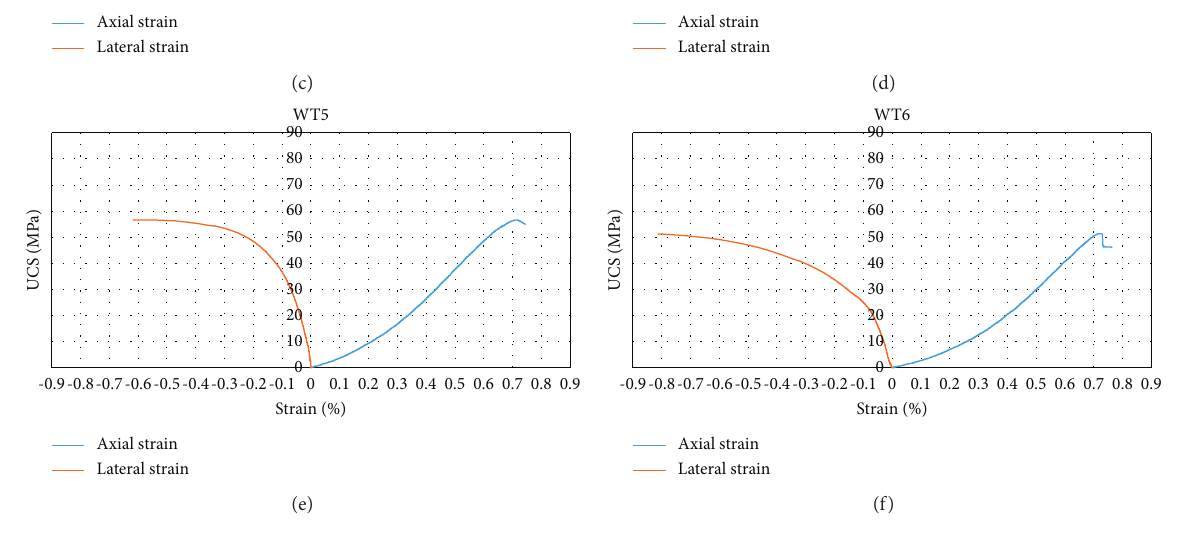
Figure 4: The stress-strain curves of sandstone with diffident water contents. Table 2: The function and R 2 used to fit UCS and ω . Fitting function R 2 Polynomial